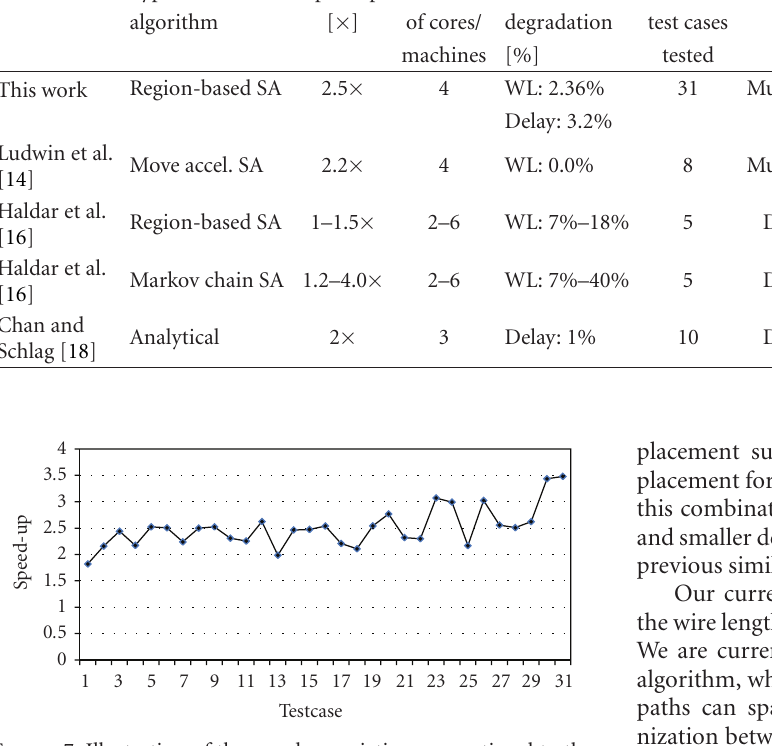
Figure 7: Illustration of the speedup variation proportional to the circuit size. The first circuit on the x -axis is the smallest and the last one is the largest.